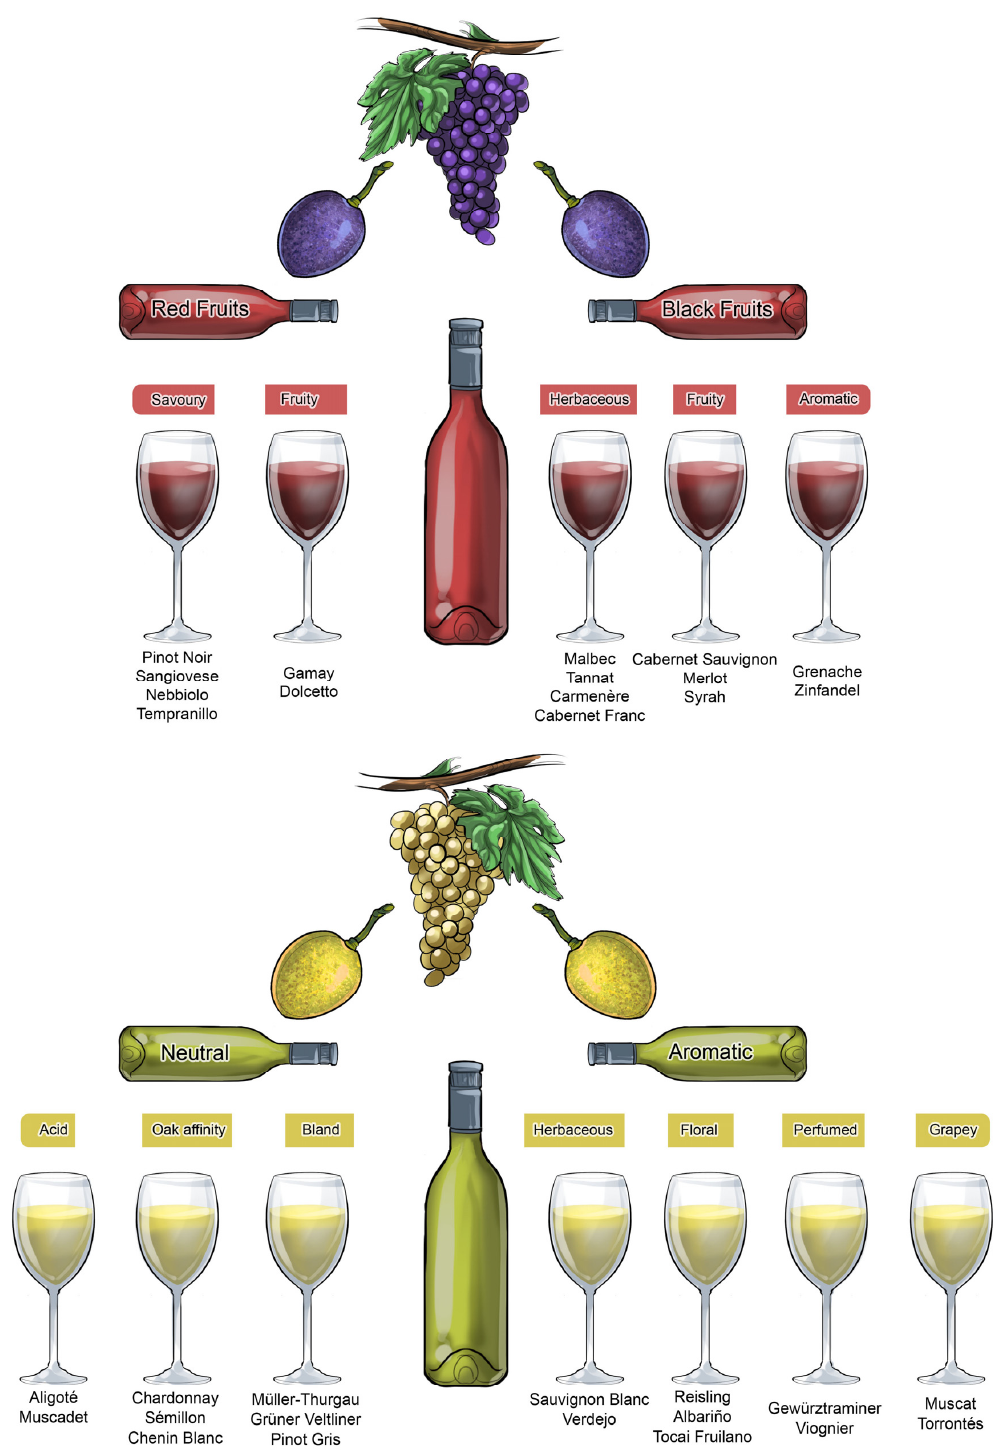
Figure 20. The main classes of grape-derived aromas that determine the recognisable and distinctive characteristics of varietal wines (adapted from [8]).